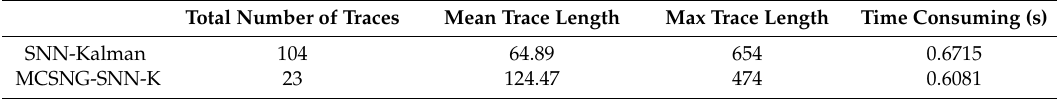
Table 6. The performance indexes of SNN-Kalman and